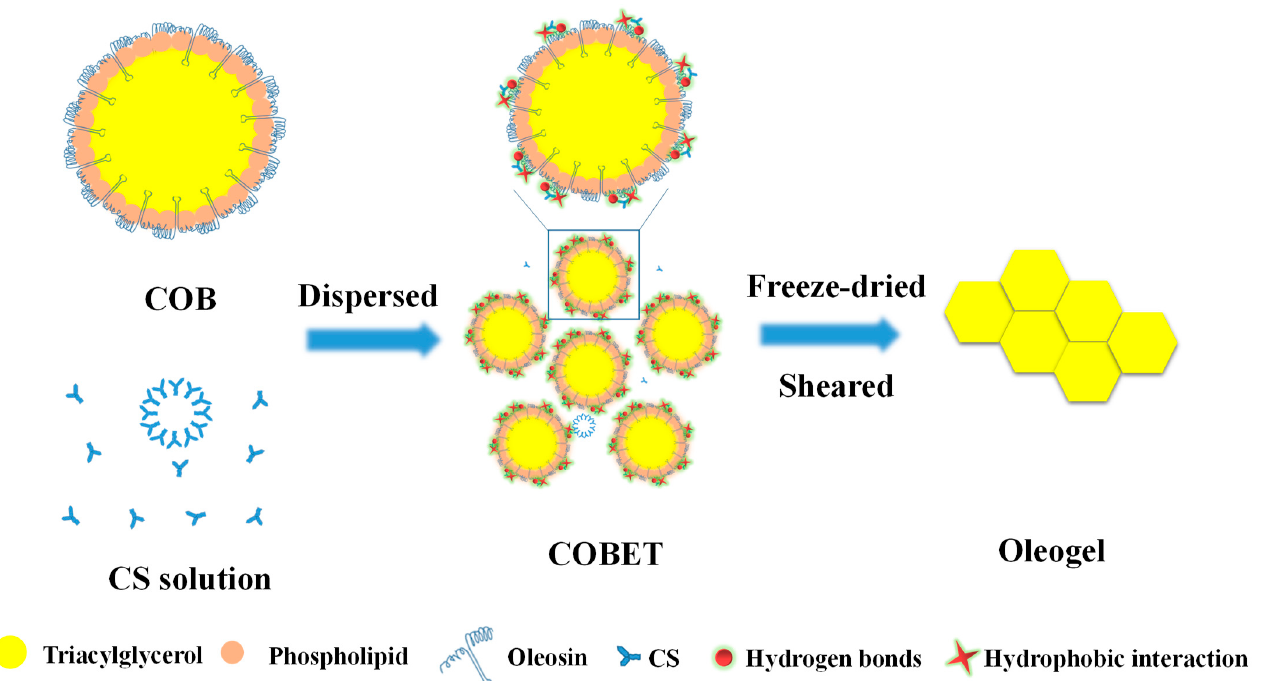
Figure 8. The possible mechanism for the development of oleogels using COBET incorporated with CS.